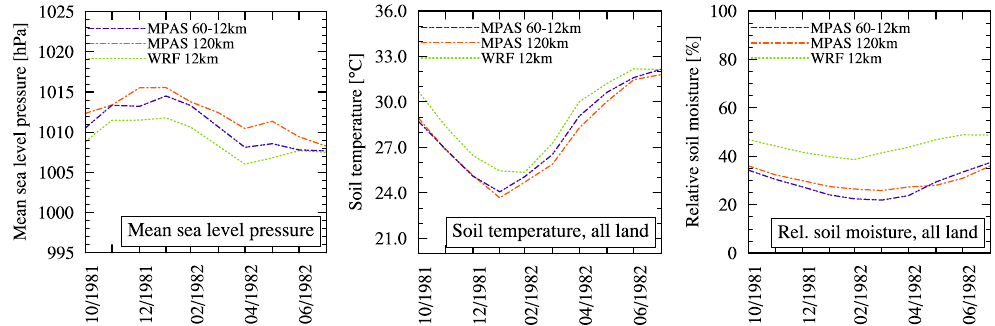
Figure 12. Annual cycle of (left) mean sea level pressure in hPa, (middle) mean soil temperature in ◦ C and (right) mean relative soil moisture in % over land for the WRF reference and the MPAS model